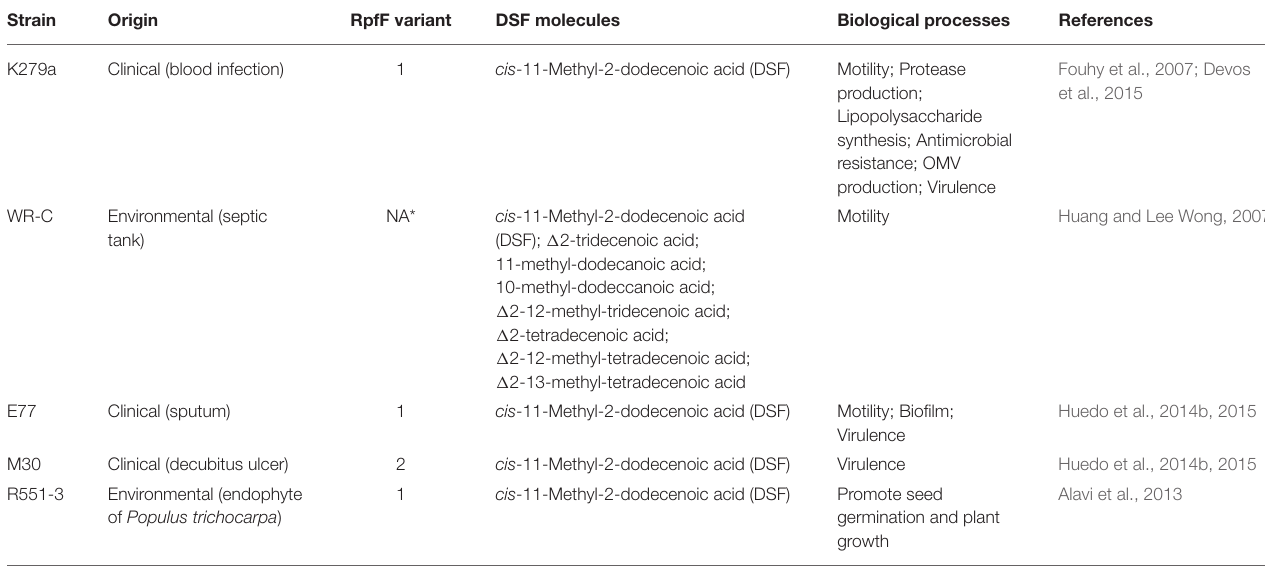
TABLE 1 | Stenotrophomonas maltophilia strains in which the diffusible signal factor (DSF) quorum sensing (QS) system has been investigated.